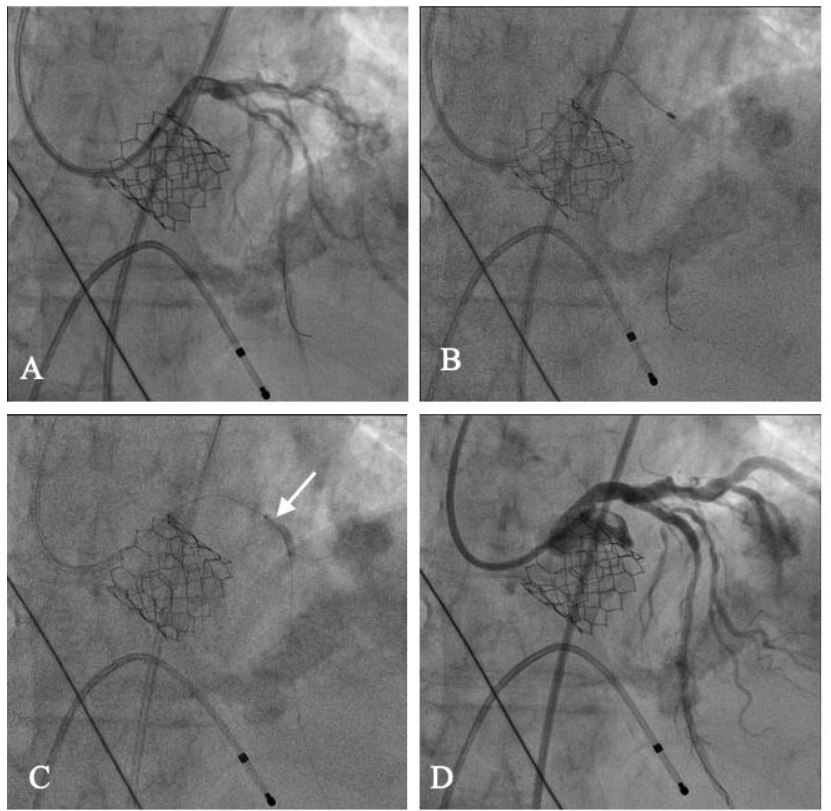
Figure 3. PCI with rotational atherectomy and stenting after TAVI (Edwards Sapien 3). ( A ) Coronary angiography after selective cannulation of left coronary artery showed severe calcific lesion of the mid left anterior descending. ( B ) Rotational atherectomy. ( C ) Predilation of the lesion with non-compliant balloon. ( D ) Final result after stent implantation.